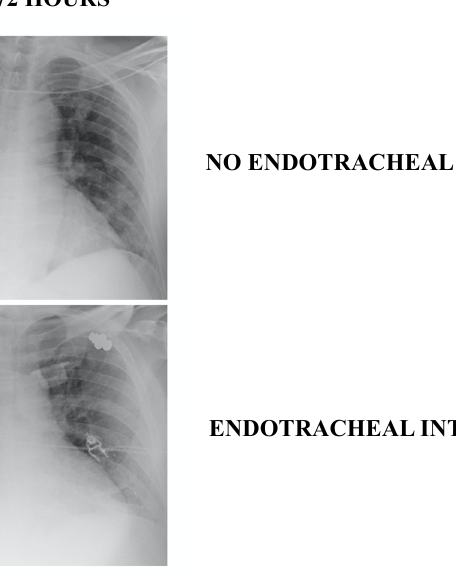
Figure 2. Chest X-rays at noninvasive ventilation (NIV) initiation ( a , b ) and after 72 h ( c , d ) in two representative male patients (53 years old in ( a , c ) and 57 years old in ( b , d )) affected by acute hypoxemic respiratory failure secondary to coronavirus disease-19. Although the two patients had similar CARE scores at NIV initiation and both showed an improvement in the score 72 h after the onset of noninvasive ventilation, only one patient received endotracheal intubation (after 2 days). Table 3. The CARE score.